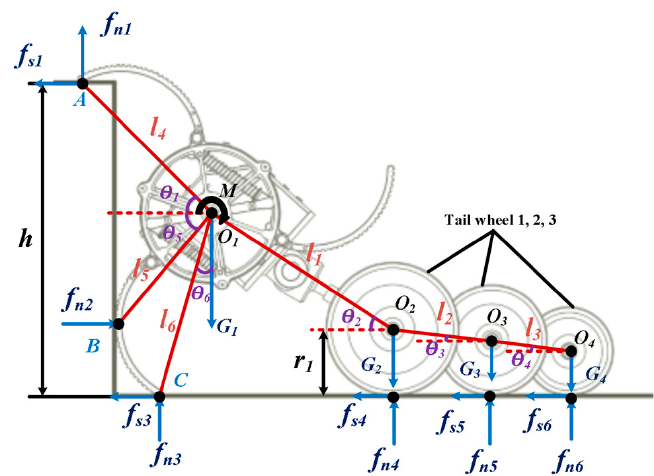
Figure 11. Moving through vertical obstacle stage I.